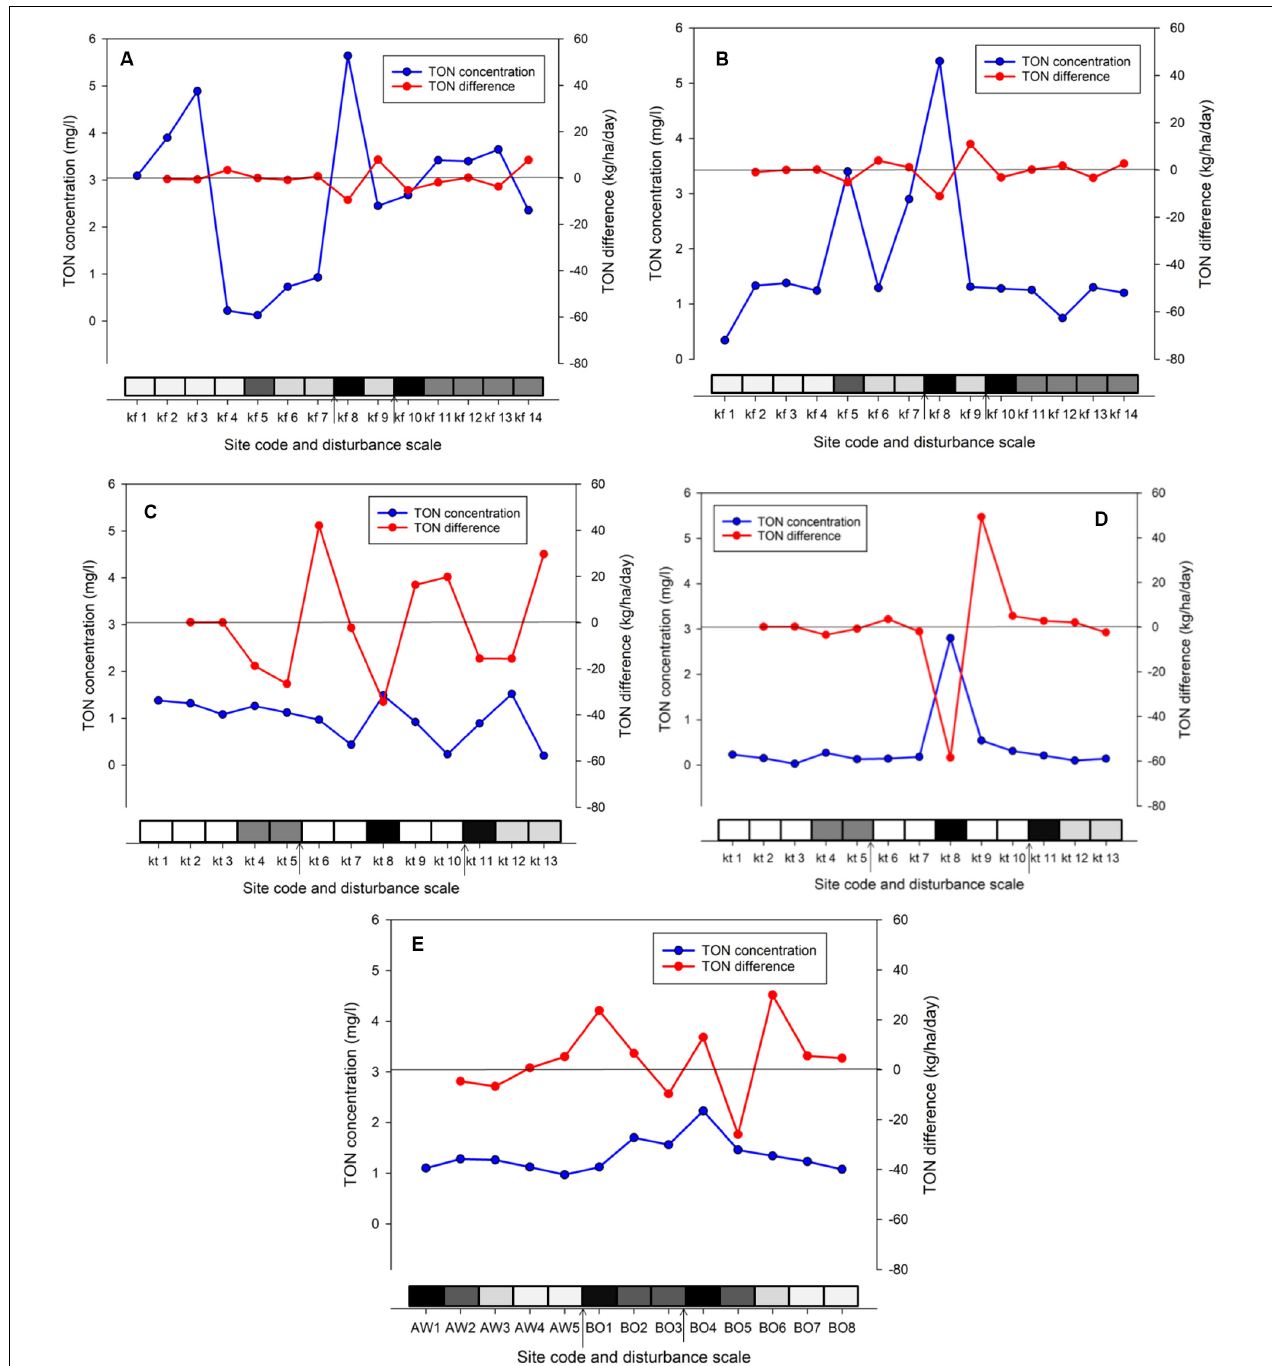
FIGURE 3 | Total Organic Nitrogen (TON) concentration and difference in Kofe (A) , Kito (C) and Awetu-Boye (E) wetlands during wet season and Kofe (B) and Kito (D) during the dry season. Disturbance condition along the wetland ranged from very low (white) to very high (black). A black arrow indicates a site where a tributary enters into the main